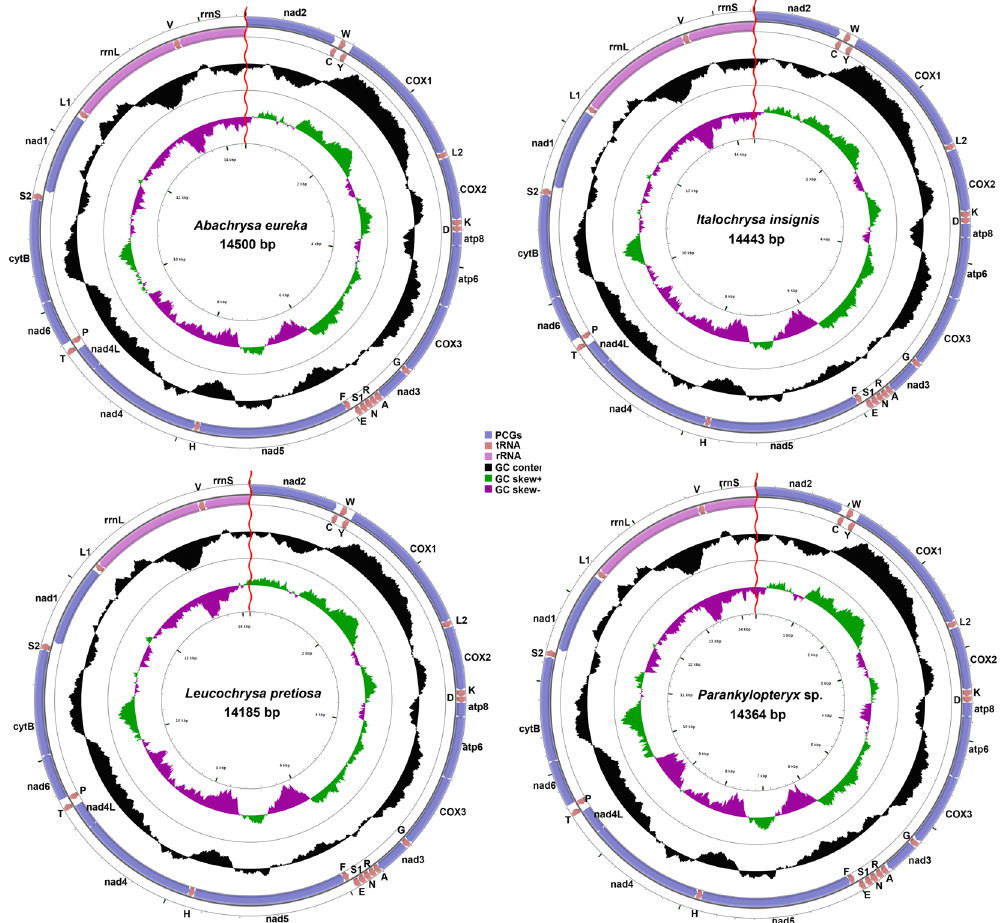
Figure 1. Mitochondrial map of the four species we sequenced. Circular maps were drawn with CGView 45 . The arrows indicated the orientation of gene transcription. The tRNAs are denoted by the color blocks and are labelled according to the IUPACIUB single-letter amino acid codes (L1: UUR; L2: CNU; S1: AGN; S2: UCN). The GC content was plotted using a black sliding window, as the deviation from the average GC content of the entire sequence. GC-skew was plotted as the deviation from the average GC-skew of the entire sequence. The inner cycle indicated the location of the genes in the mt